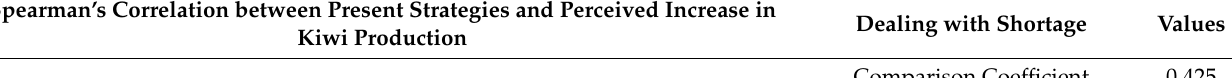
Dealing with Shortage Values Comparison Coefficient 0.425 Sig. (2-tailed) 0.003